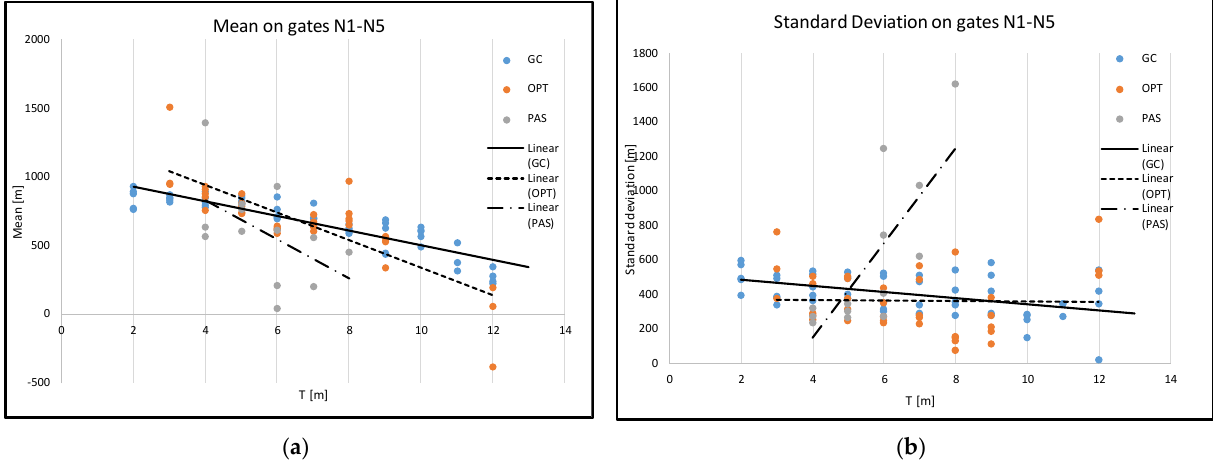
Figure 8. ( a ) The mean of the ship’s distance from the centre; ( b ) standard deviation of ship distance from the centre to the ship’s draught. Table 1. The parameter of the simple regression